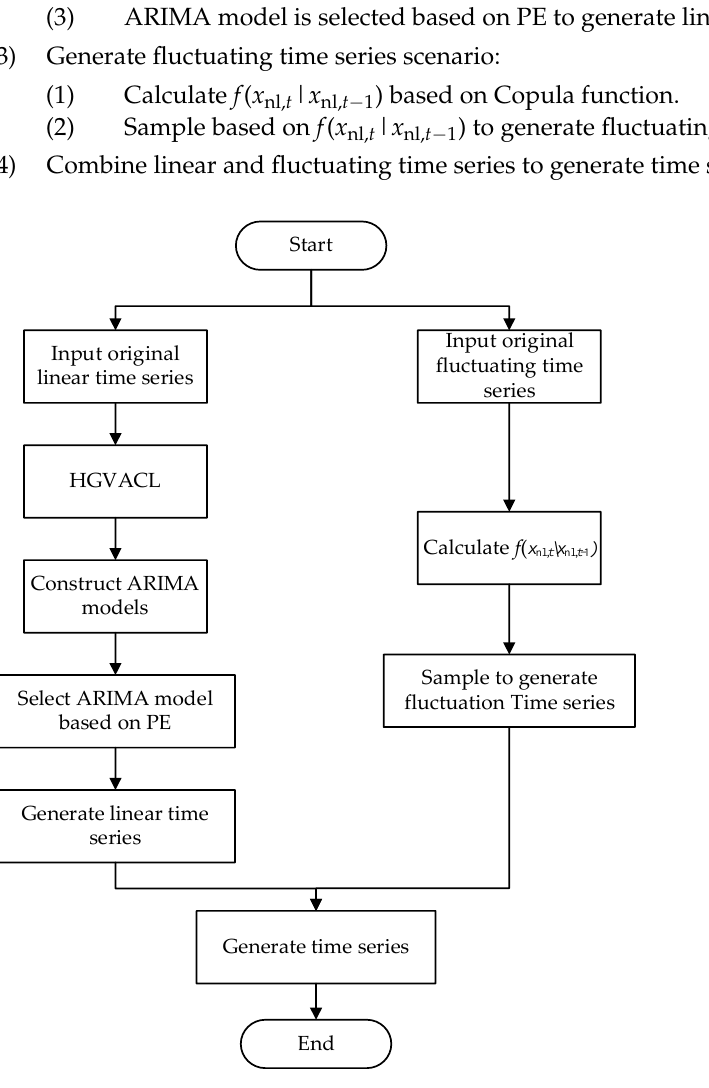
Figure 2. Procedure of proposed scenario generation approach.